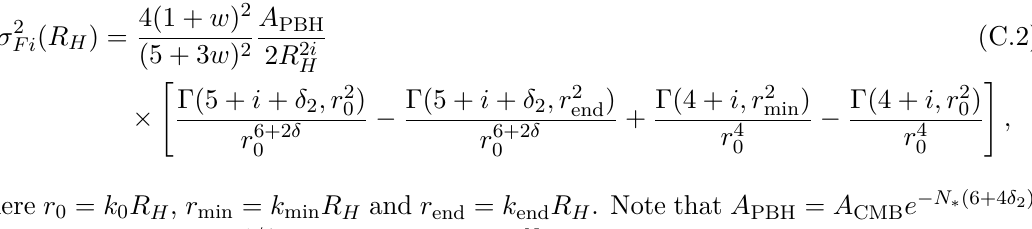
= 1 from various statistical approaches with N PBH